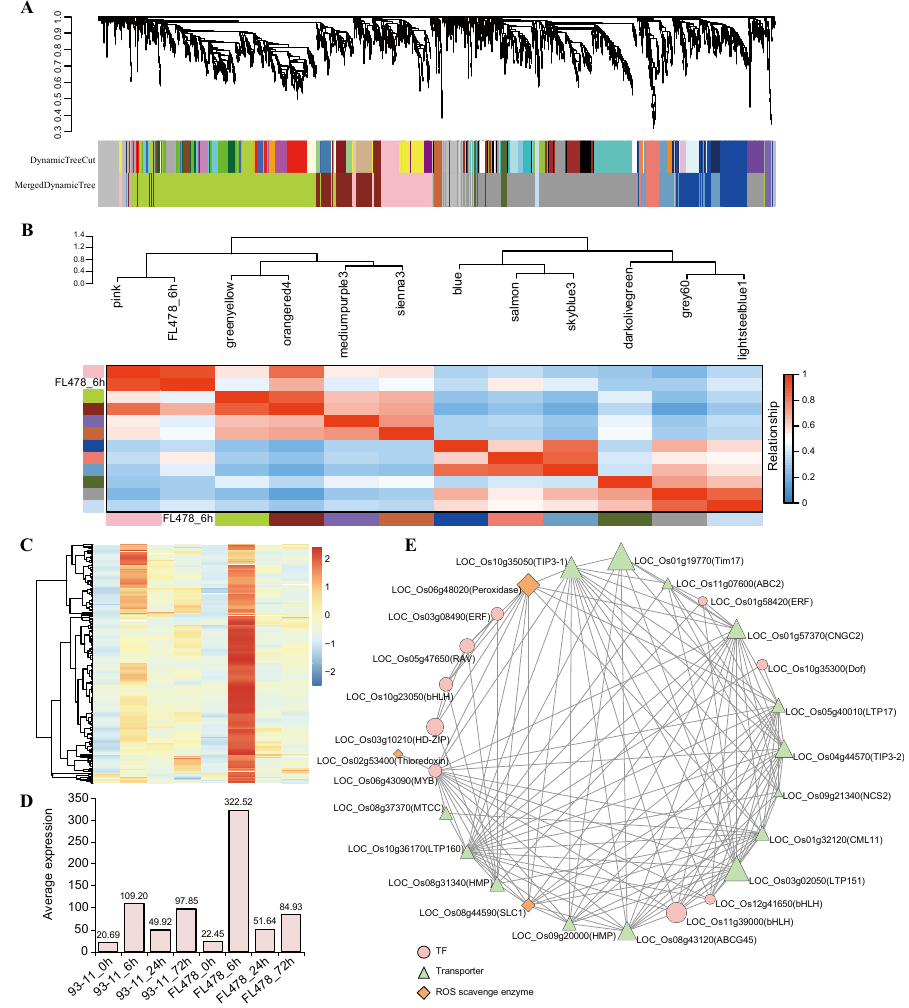
Figure 5. The weighted gene co-expression network analysis. ( A ) The hierarchical cluster tree constructed with a total of 3234 DEGs. The eleven co-expression modules are indicated by the corresponding colors. ( B ) The pink module significantly related to the gene expression of FL478 at 6 h upon salt stress. ( C ) Expression profiles of 274 DEGs in the pink module. ( D ) The average expression of 274 DEGs in the pink module. ( E ) Co-expression networks of salt-tolerance genes related to TFs, transporters, and ROS scavenging. The shape and color represent gene types, and the graph size represents fold-change of genes at 6 h compared with 0 h in FL478 upon salt